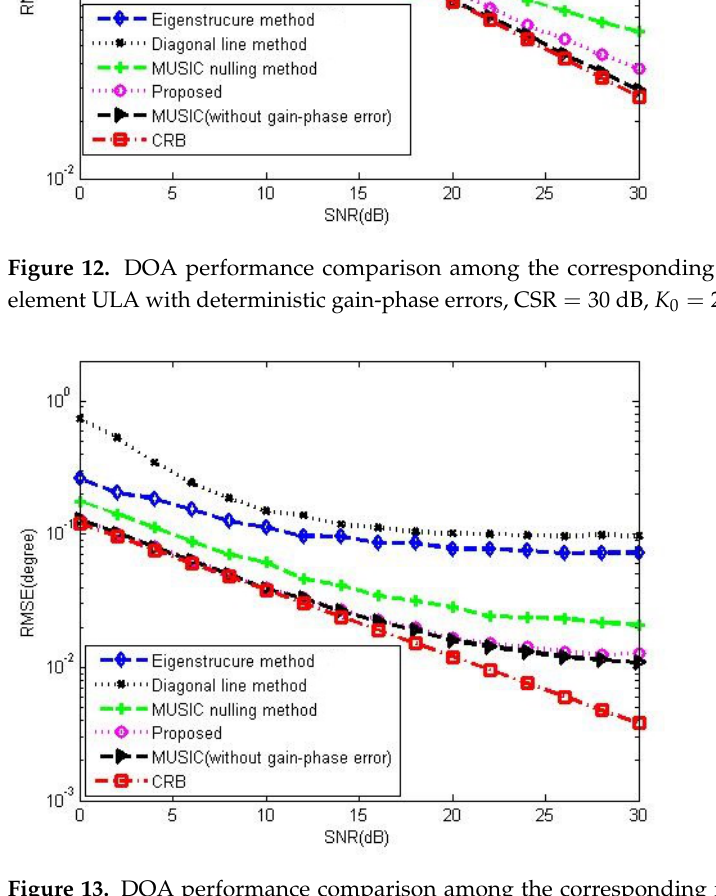
Figure 13. DOA performance comparison among the corresponding methods versus SNR in 16- element ULA with random gain-phase errors, CSR = 30 dB, K 0 = 20, T = 80, N = 40, T 0 =